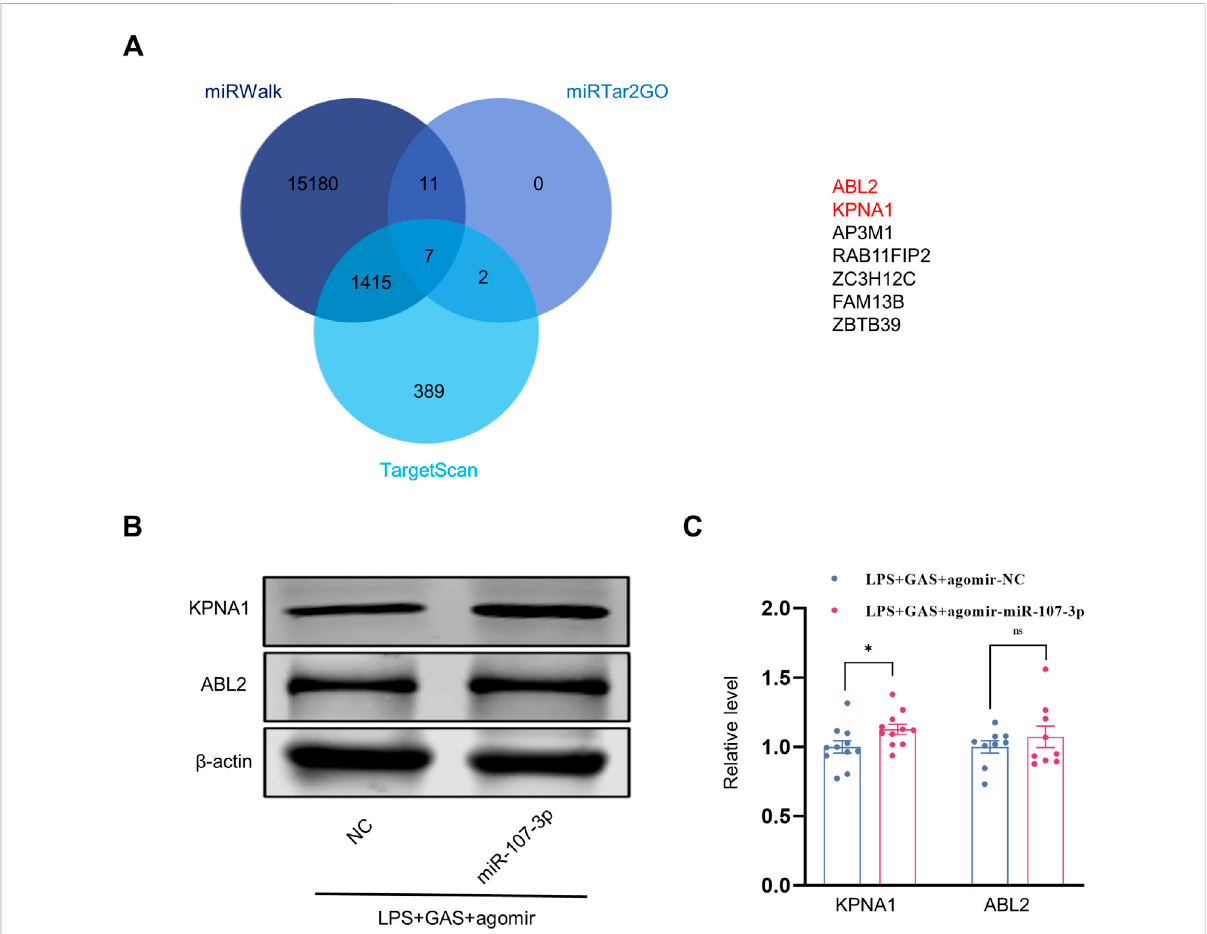
FIGURE 6 Prediction and veri fi cation of the target molecular of miR-107-3p. (A) Venn plots of downstream target molecules were screened by three databases (miRWalk, TargetScan, and miRTar2GO). (B,C) Representative protein bands and the histograms of bands intensity analysis of ABL2 and KPNA1 inthe hippocampus. Values are represented as means ± SEM. n ≥ 9. * p < 0.05 versus LPS + GAS + agomir NC group. LPS, lipopolysaccharide; GAS,